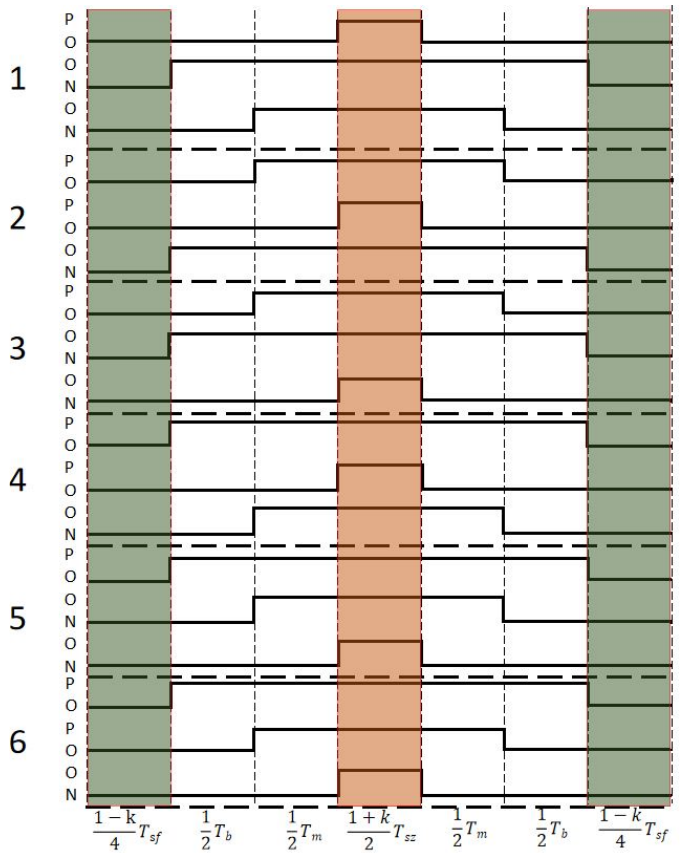
Figure 10. Modulation timing diagram of SVPWM after adding midpoint balance control.